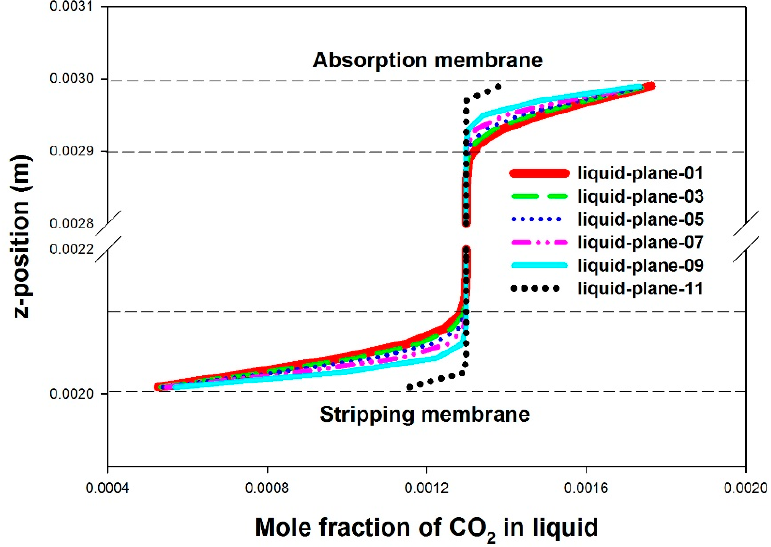
Figure 7. PE-HASMC CO 2 concentration profiles in liquid channel (BC, liquid entry at x = 0.02 m and liquid-plane-11).